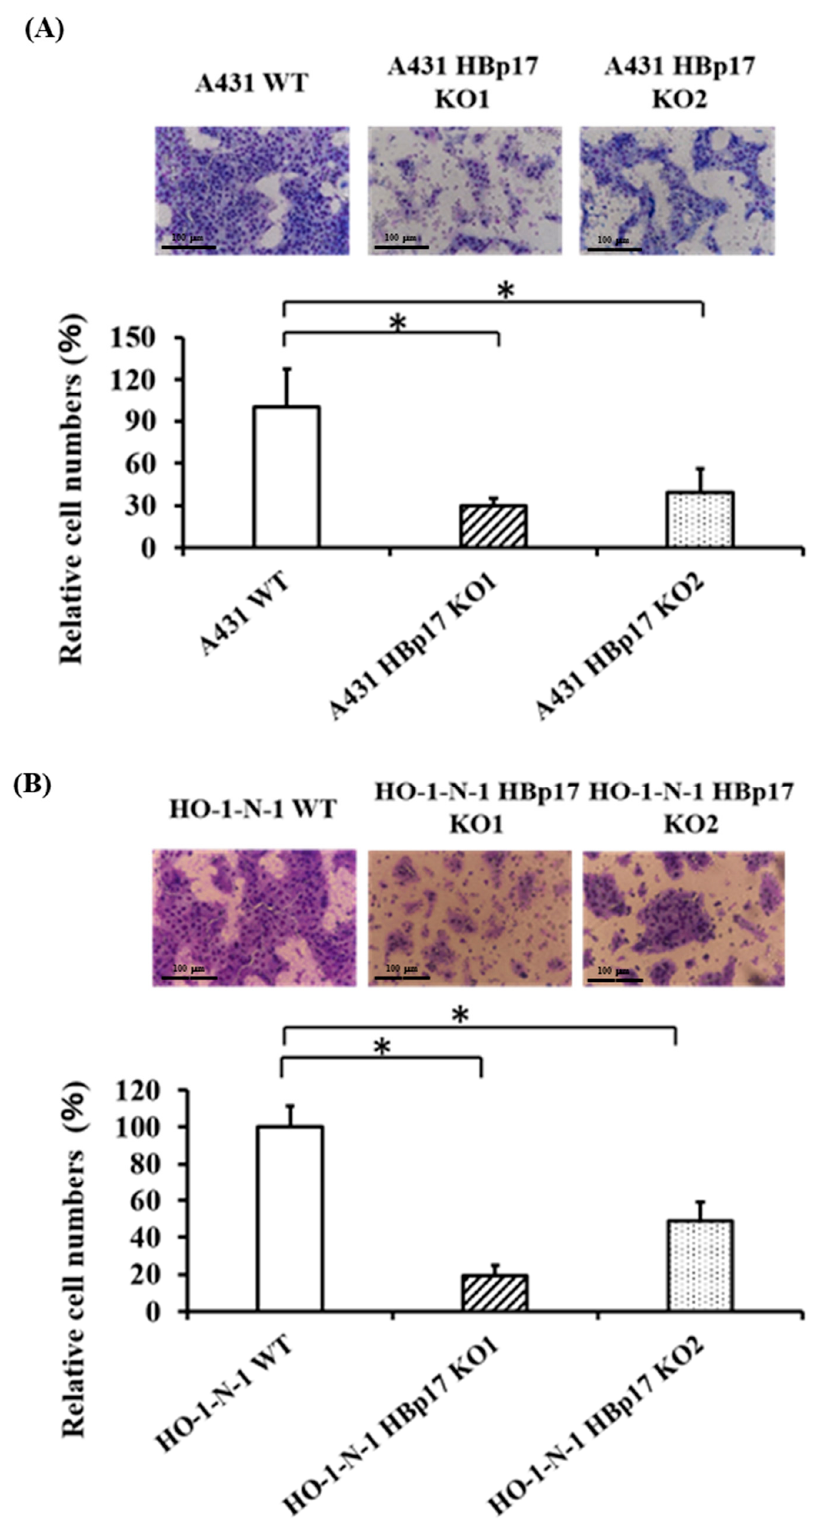
Figure 4. Knockout of HBp17 inhibits mobility of A431 and HO-1-N-1 cells. A431-HBp17-KO1, -KO2, and A431-WT ( A ) and HO-1-N-1-HBp17-KO1, -KO2, and HO-1-N-1-WT ( B ) cells were added to Transwell inserts. Cells migrating across the insert were counted after incubation for 24 h at 37 ◦ C. Experiments were performed in triplicate, with the data presented as means ± SD. * p < 0.05.